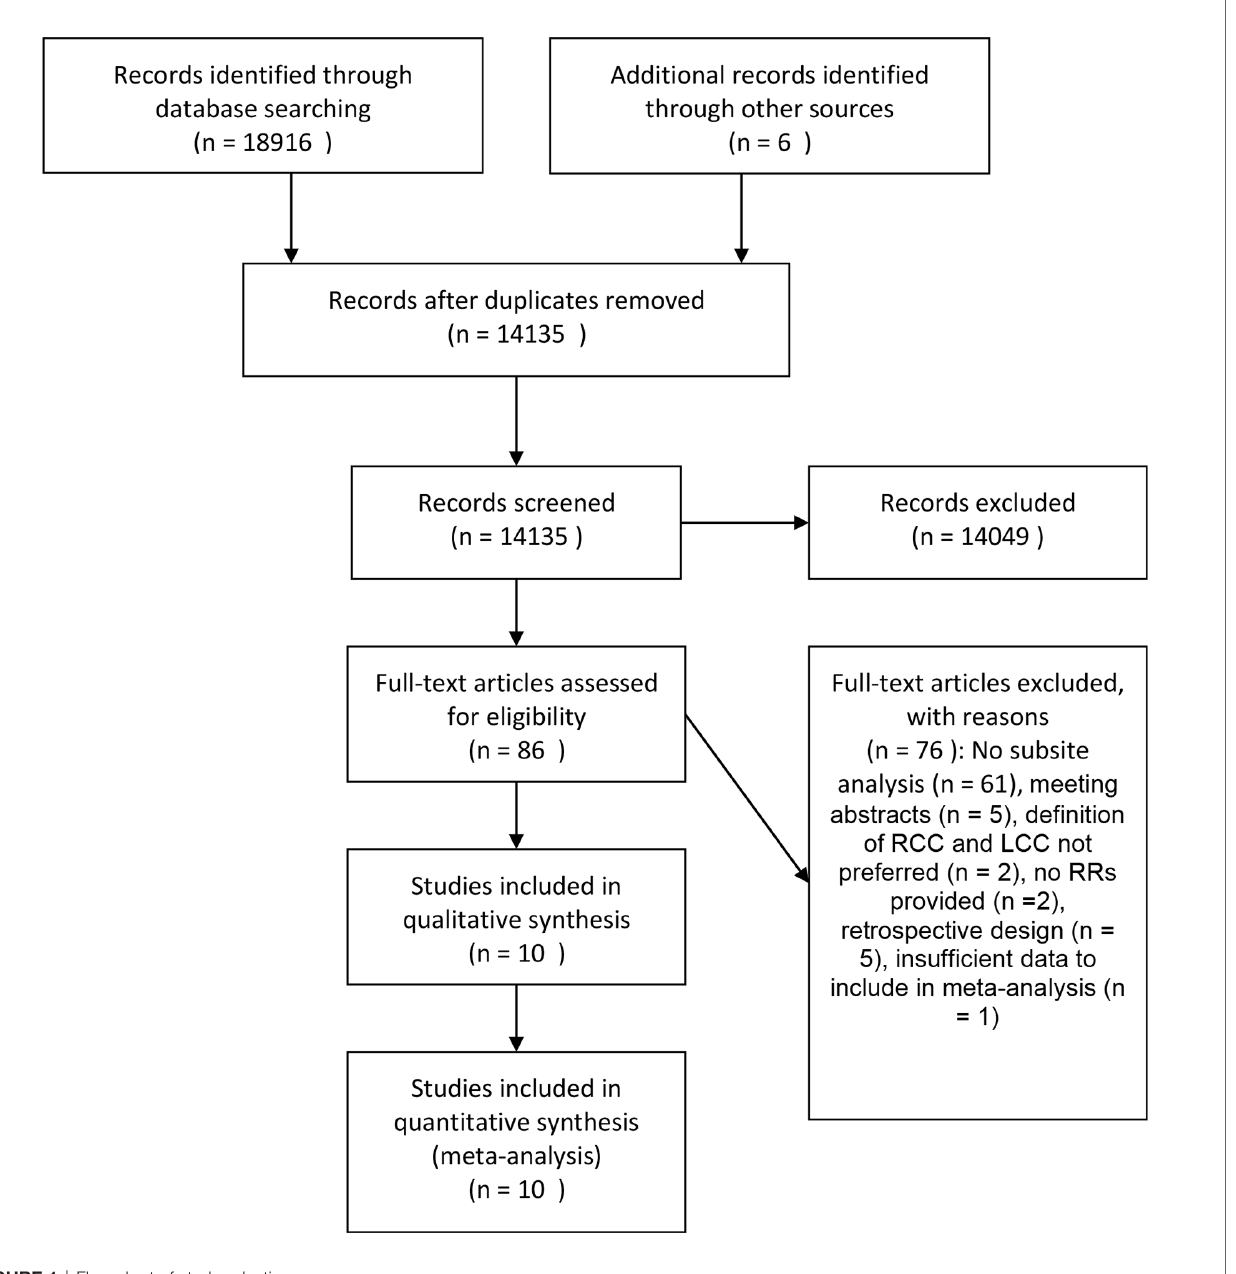
FIGURE 1 | Flow chart of study